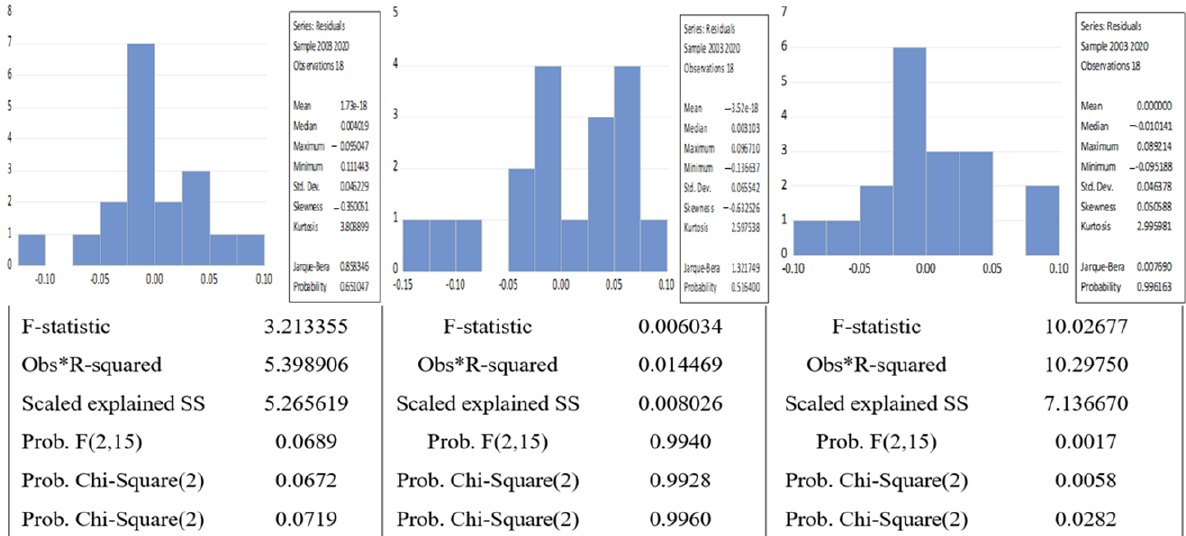
Figure 5. Results of the Breusch–Pagan–Godfrey heteroskedasticity test for Test 1.